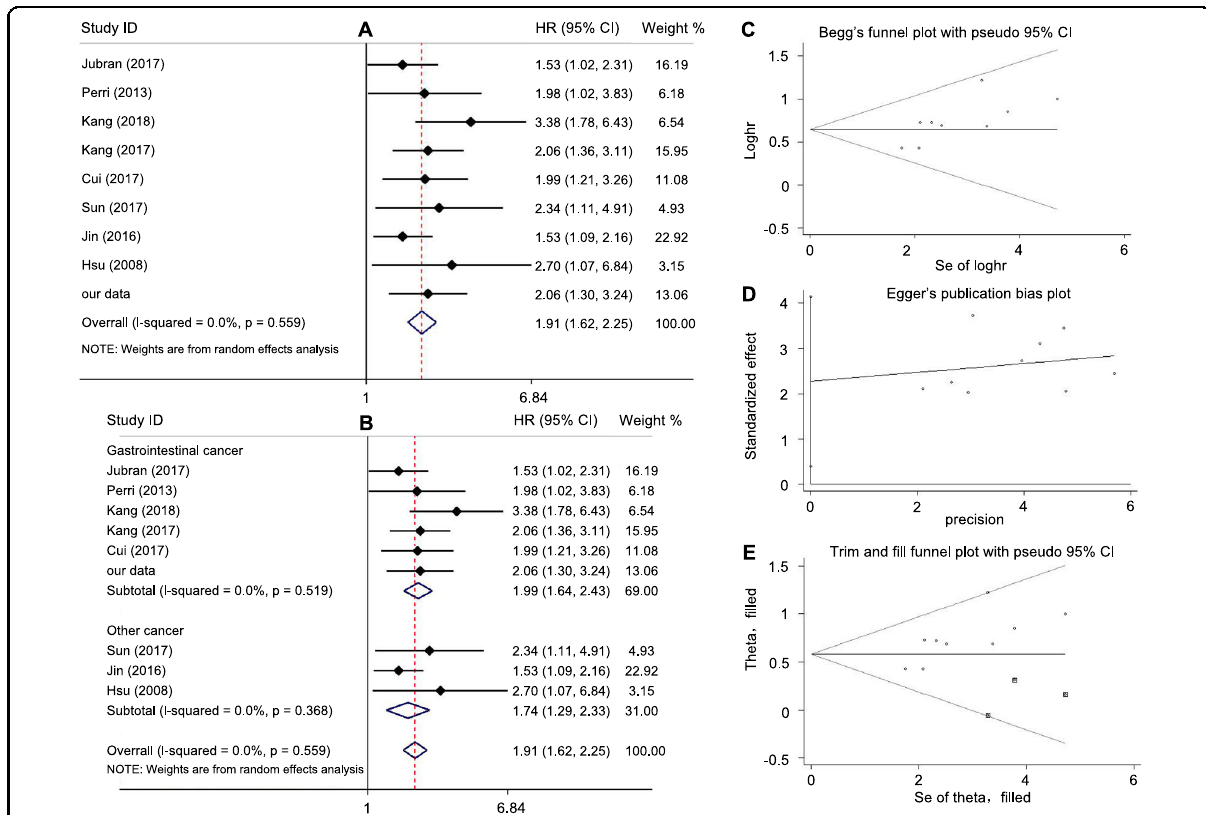
Fig. 7 Meta-analysis of the high level of GRP75 with poor prognosis. A Frost blot of the association between overall survival and GRP75 expression. B Analysis based on cancer type, data were divided into gastrointestinal cancers and other cancers. C and D Begg ’ s and Egger ’ s publication bias plot of studies included in this analysis. E The trim and fi ll method to exclude publication